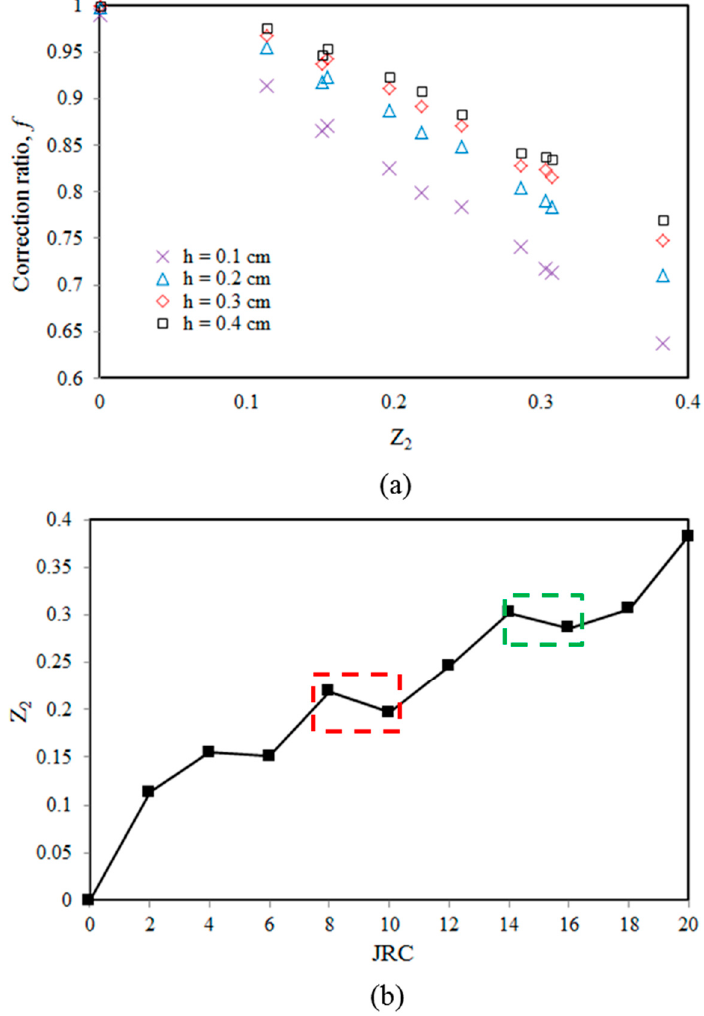
Figure 7. The relationship between the correction factor, the JRC and Z 2 : ( a ) relationship between Z 2 and the JRC, ( b ) relationship between the correction factor and Z 2